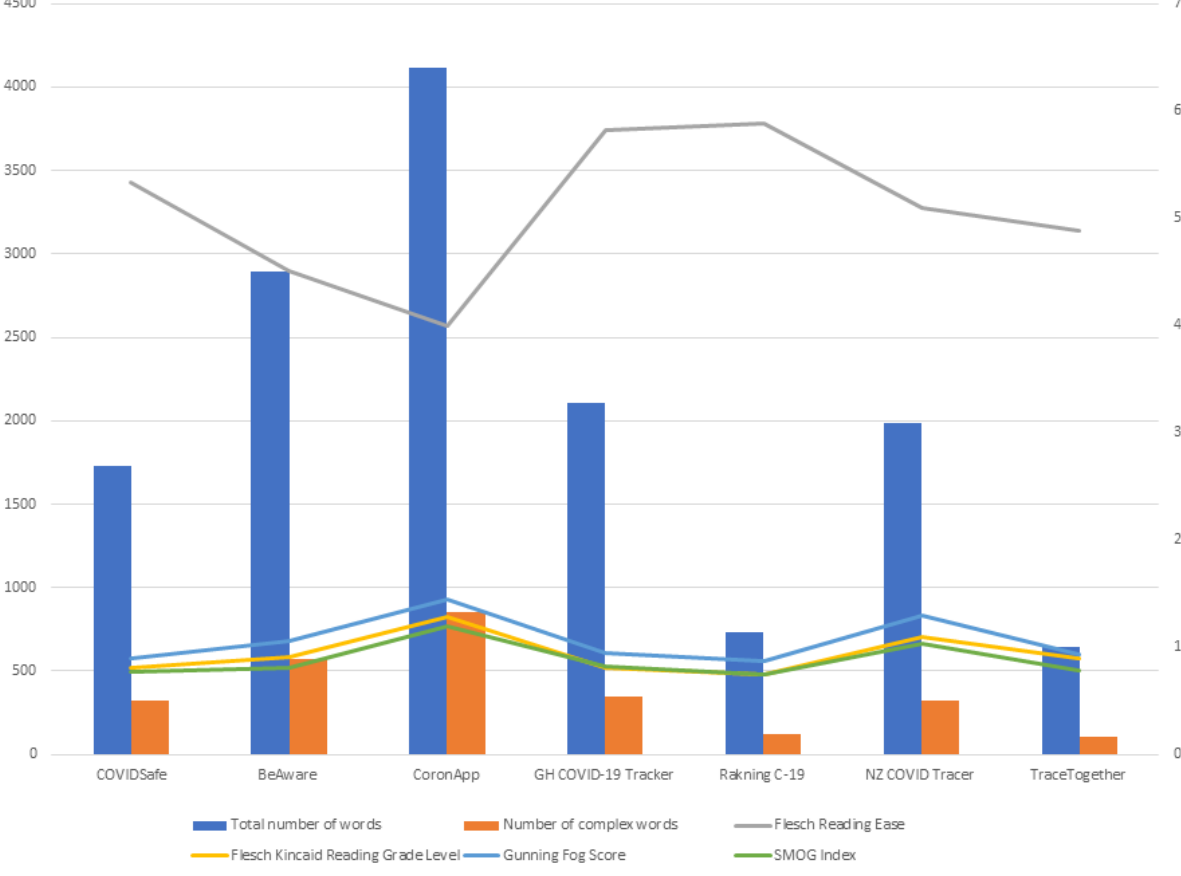
Figure 1. Overview of readability scores for each COVID-19 contact-tracing app